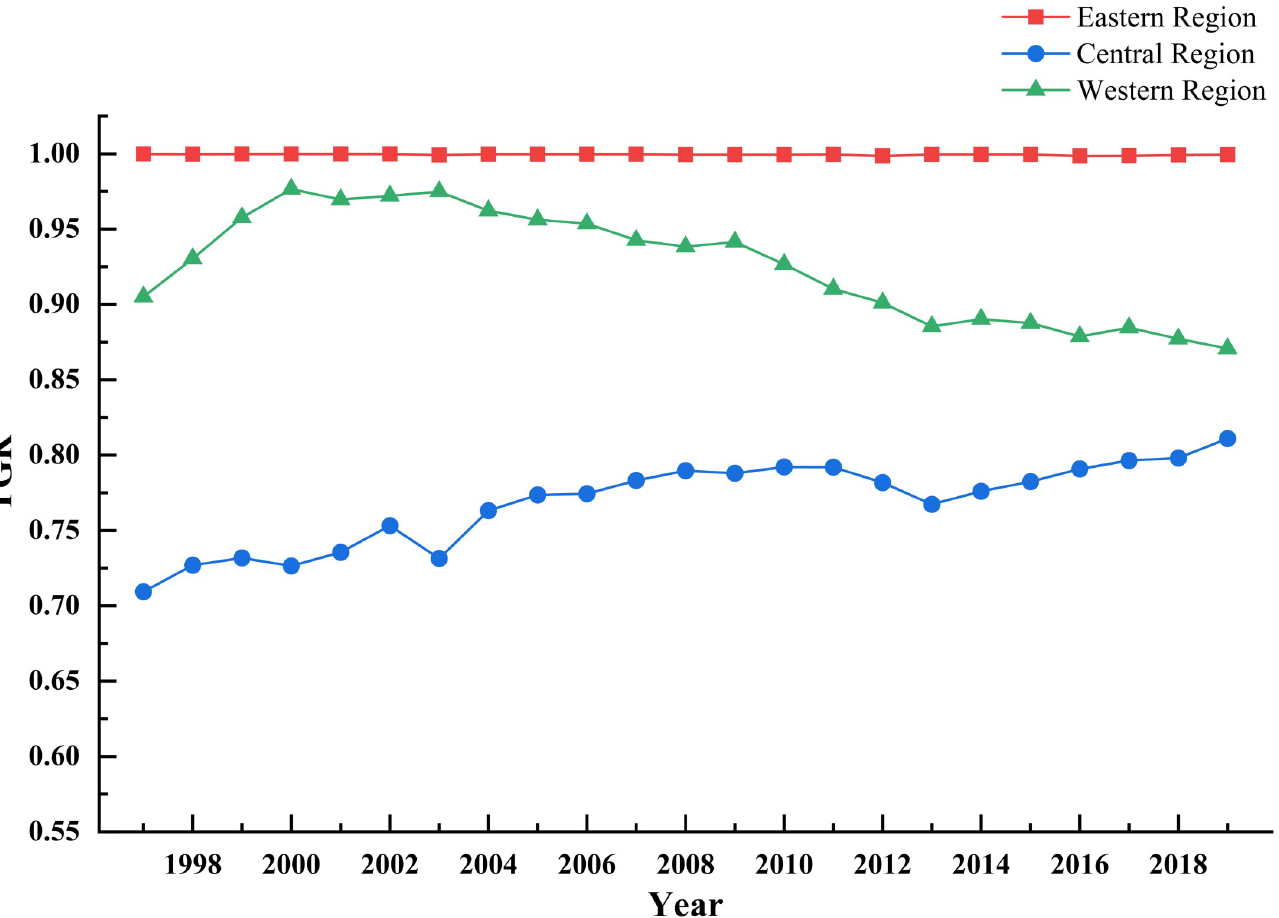
Fig 5. Changes in GMP in the eastern, central and western regions from 1997 to